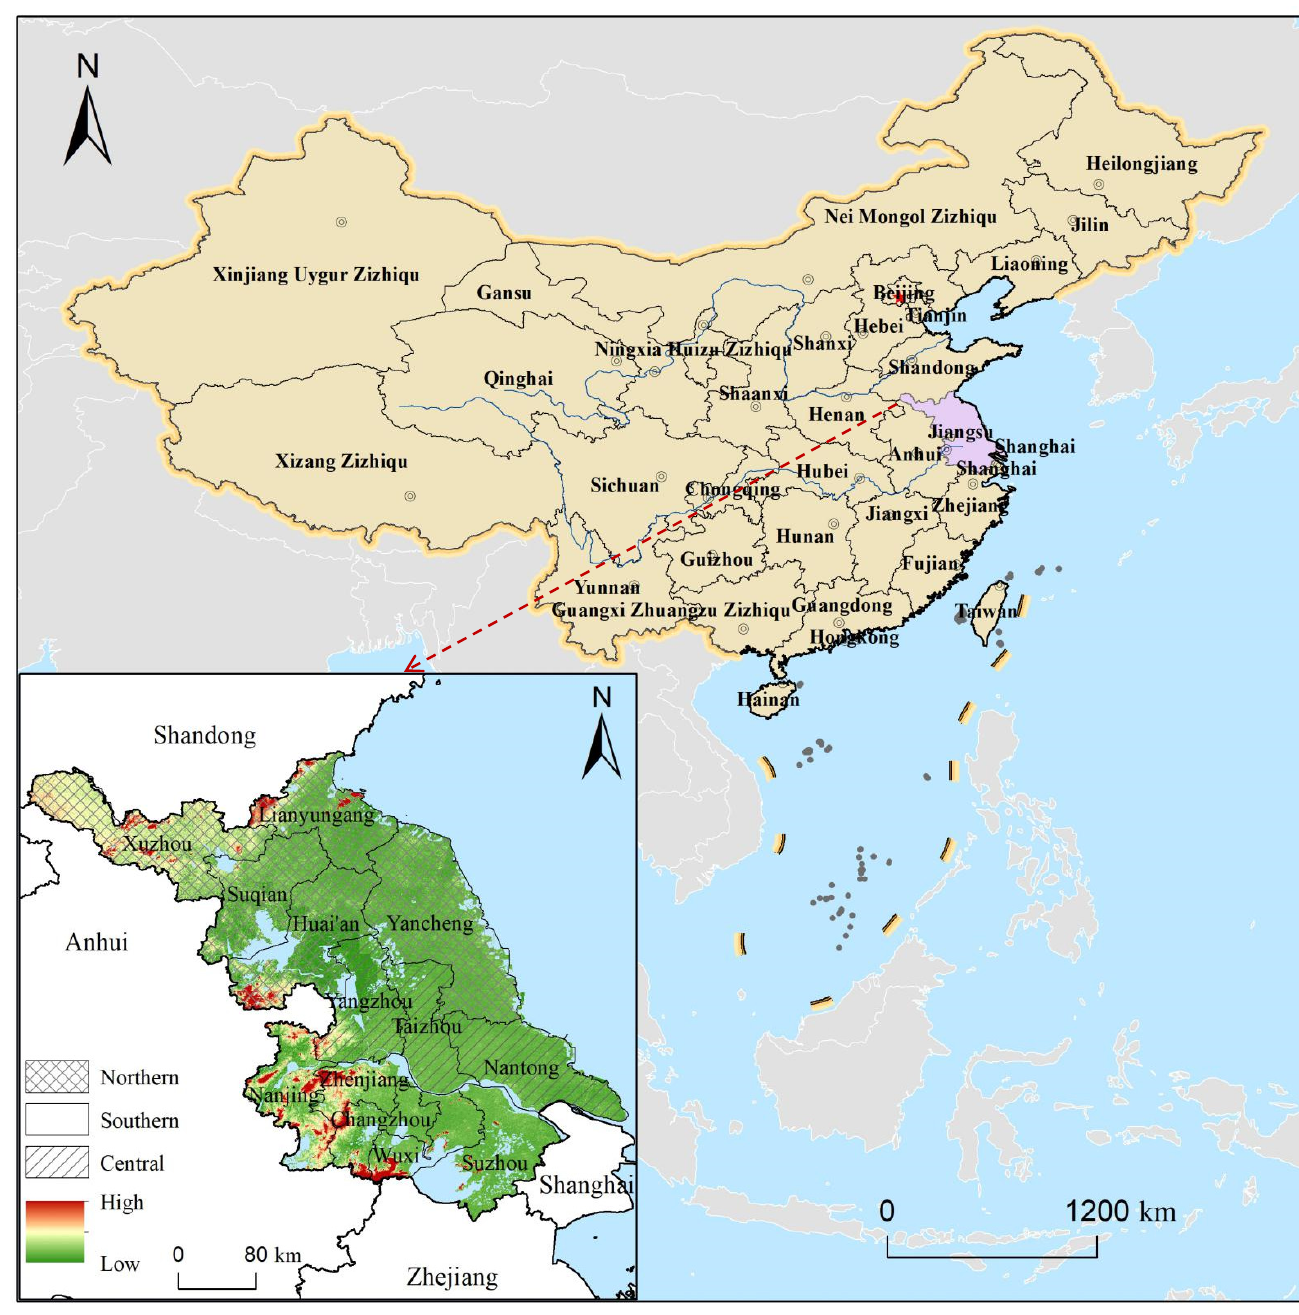
Figure 1. Map of Jiangsu province location.